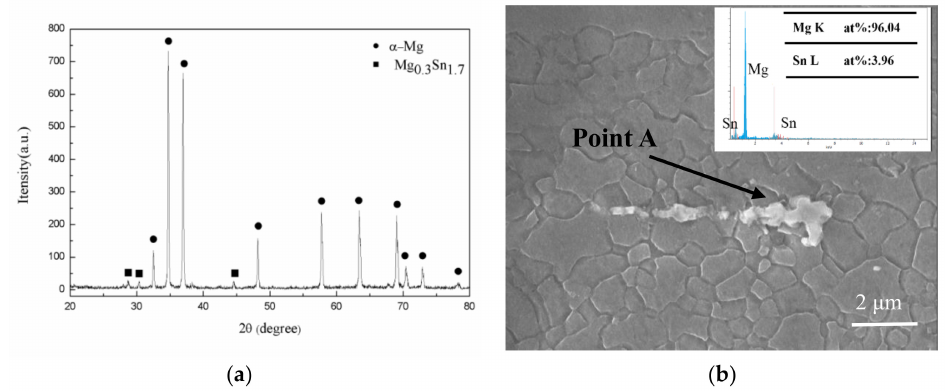
Figure 2. ( a ) X-ray diffraction pattern and ( b ) secondary phase with energy dispersive spectrometer (EDS) result of the extruded